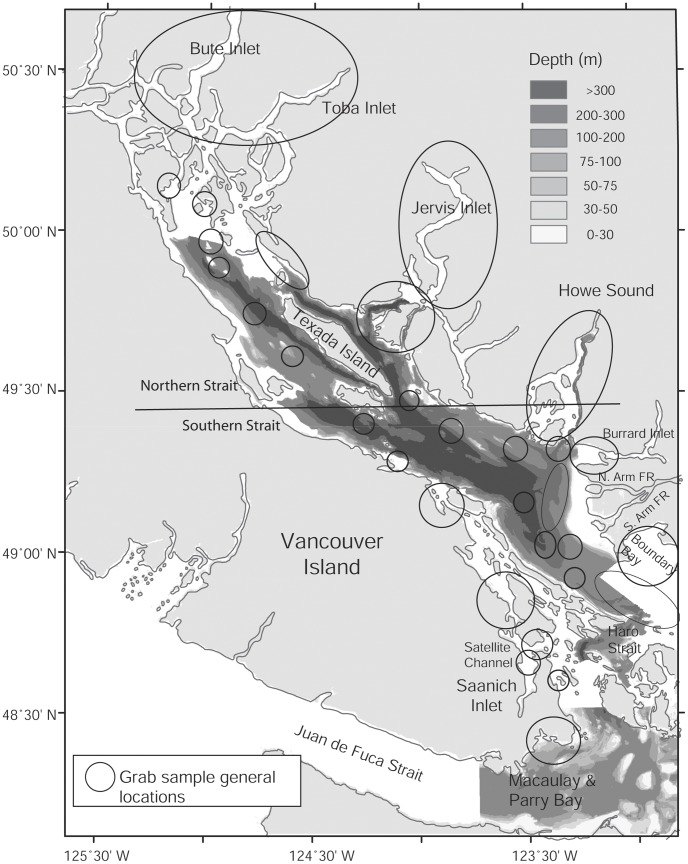
Map of general study locations of macrobenthic grab sampling surveys compiled in the Strait of Georgia database (coastal British Columbia, Canada).Circles indicate locations of grab samples. Line indicates demarcation between Northern and Southern Strait of Georgia.